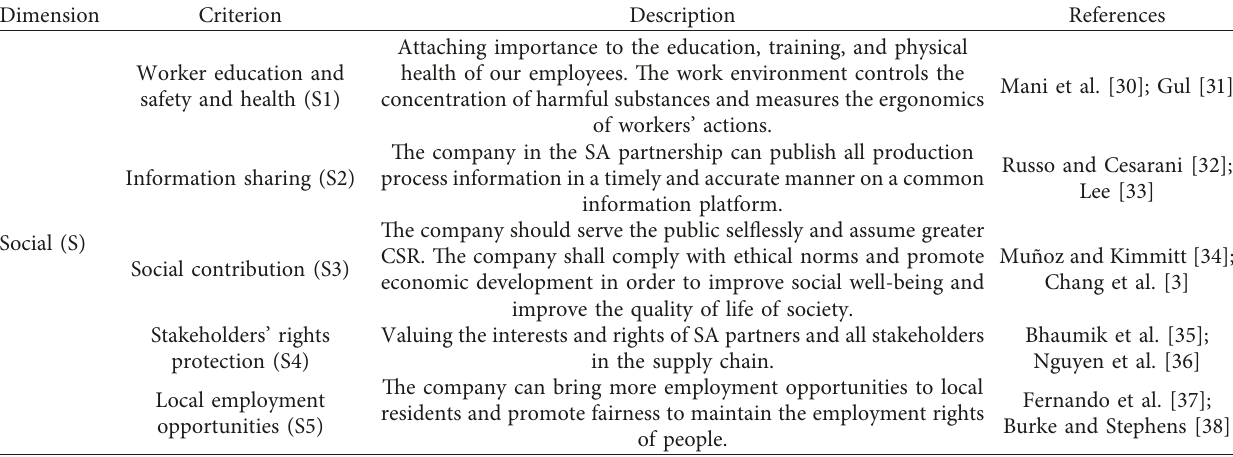
Table 3: The social dimension and its